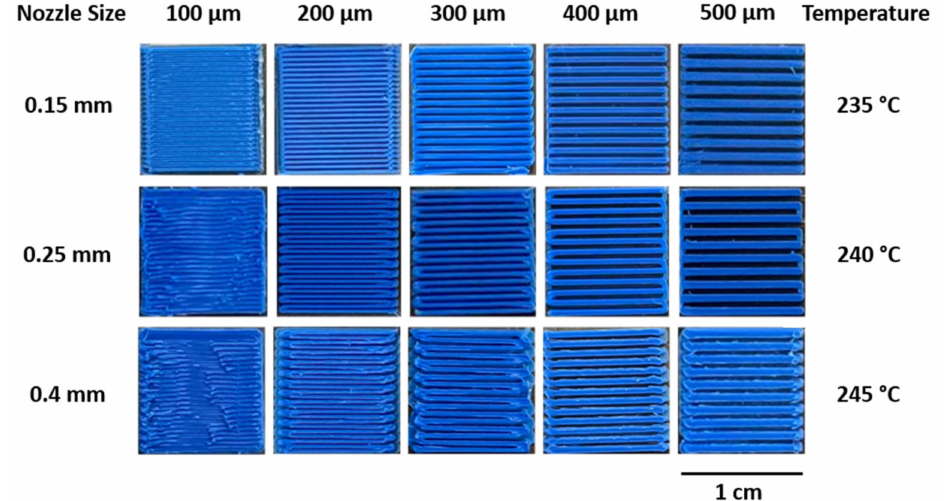
Figure 2. Printed patterns for FDM optimization. A pattern of lines and alternating gaps of equal widths were printed at 100, 200, 300, 400 and 500 µ m widths. At their optimal temperatures, the smallest feature sizes were 100, 200 and 400 µ m for 0.15, 0.25 and 0.4 mm nozzles,